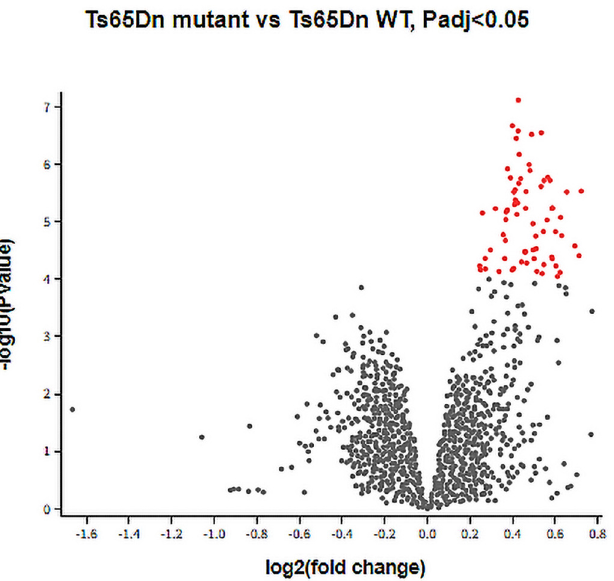
Figure 2. DEGs between Ts65Dn mutant and Ts65Dn WT groups. A volcano plot showing DEGs between the Ts65Dn mutant and Ts65Dn WT groups in the GSE149465 dataset. Grey dots: genes with no significant difference between groups, red dots: significantly upregulated DEGs based on adjusted p value < 0.05 and |logFC| ≥ 1. Table 1. Upregulated DSCR genes in the Ts65Dn mutant group compared to the Ts65Dn WT group.